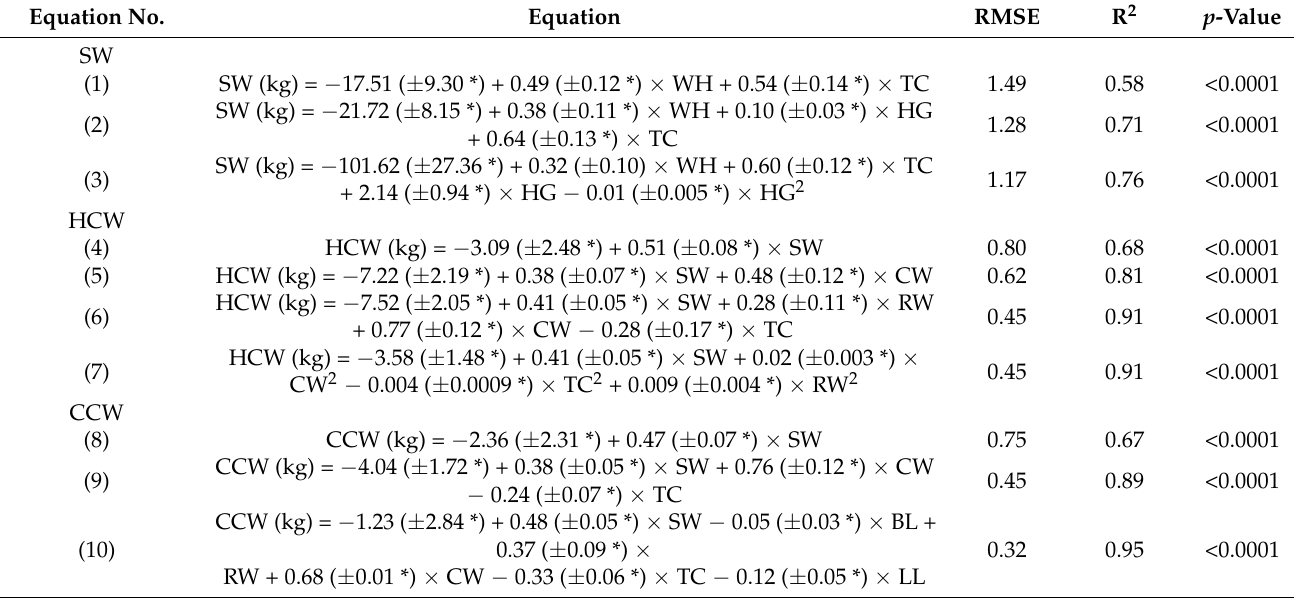
Table 3. Regression equations for predicting carcass traits of sheep finished in tropical pastures through biometric measure- ments. Values in parentheses are the PEs of the parameter estimates. Equation